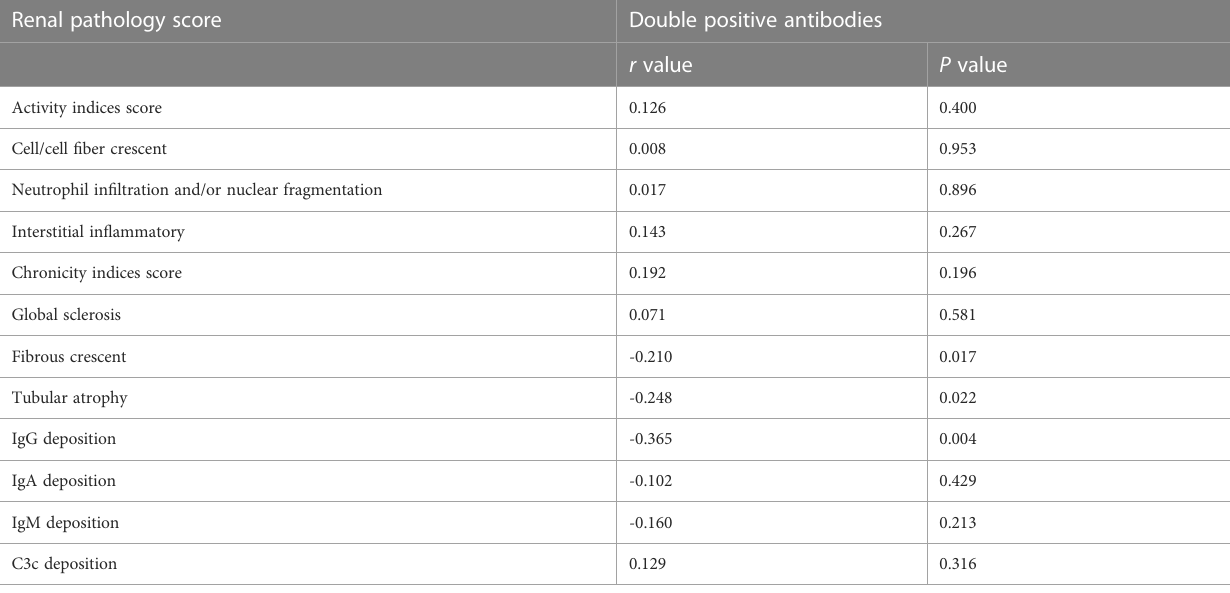
TABLE 5 Comparisons of pathological manifestations of patients with and without double positive antibodies. Renal pathology